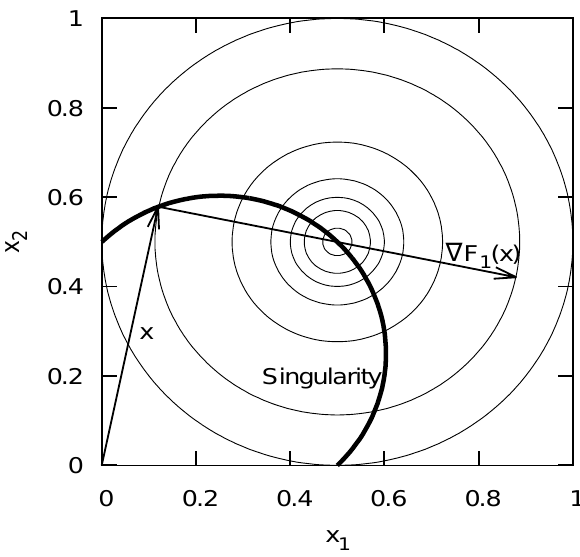
Fig. 1. Example of a singularity in the tagging method. The forcing term F 1 ( x ) is shown in thin lines with isolines 0.,0.1, 0.2, 0.23, 0.24, 0.245, and 0.249 with a maximum in the middle. Thick lines indicate the location of the singularities x ∇ F 1 ( x ) = 0. The arrows give an example.